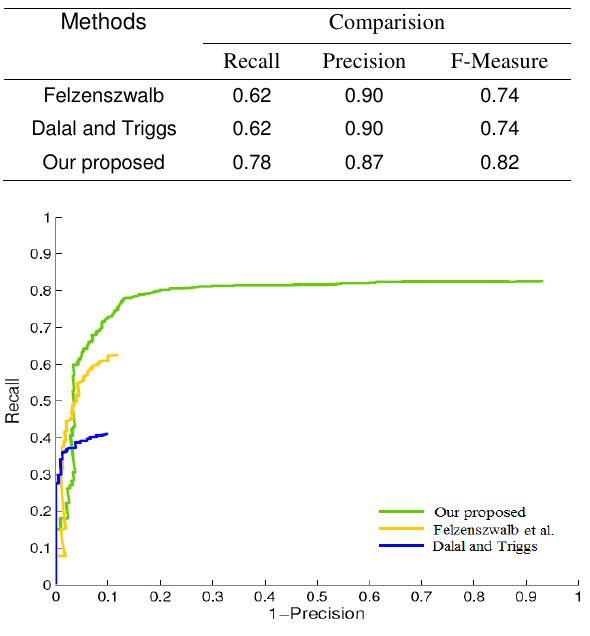
Figure 7. Recall-precision curves (RPC) of Caviar dataset